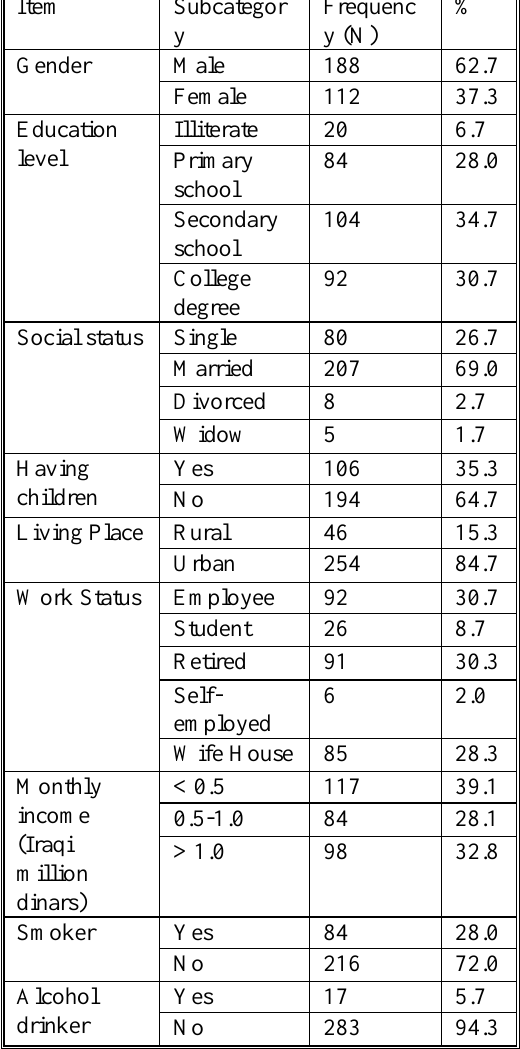
Table 1. The sociodemographic features of the